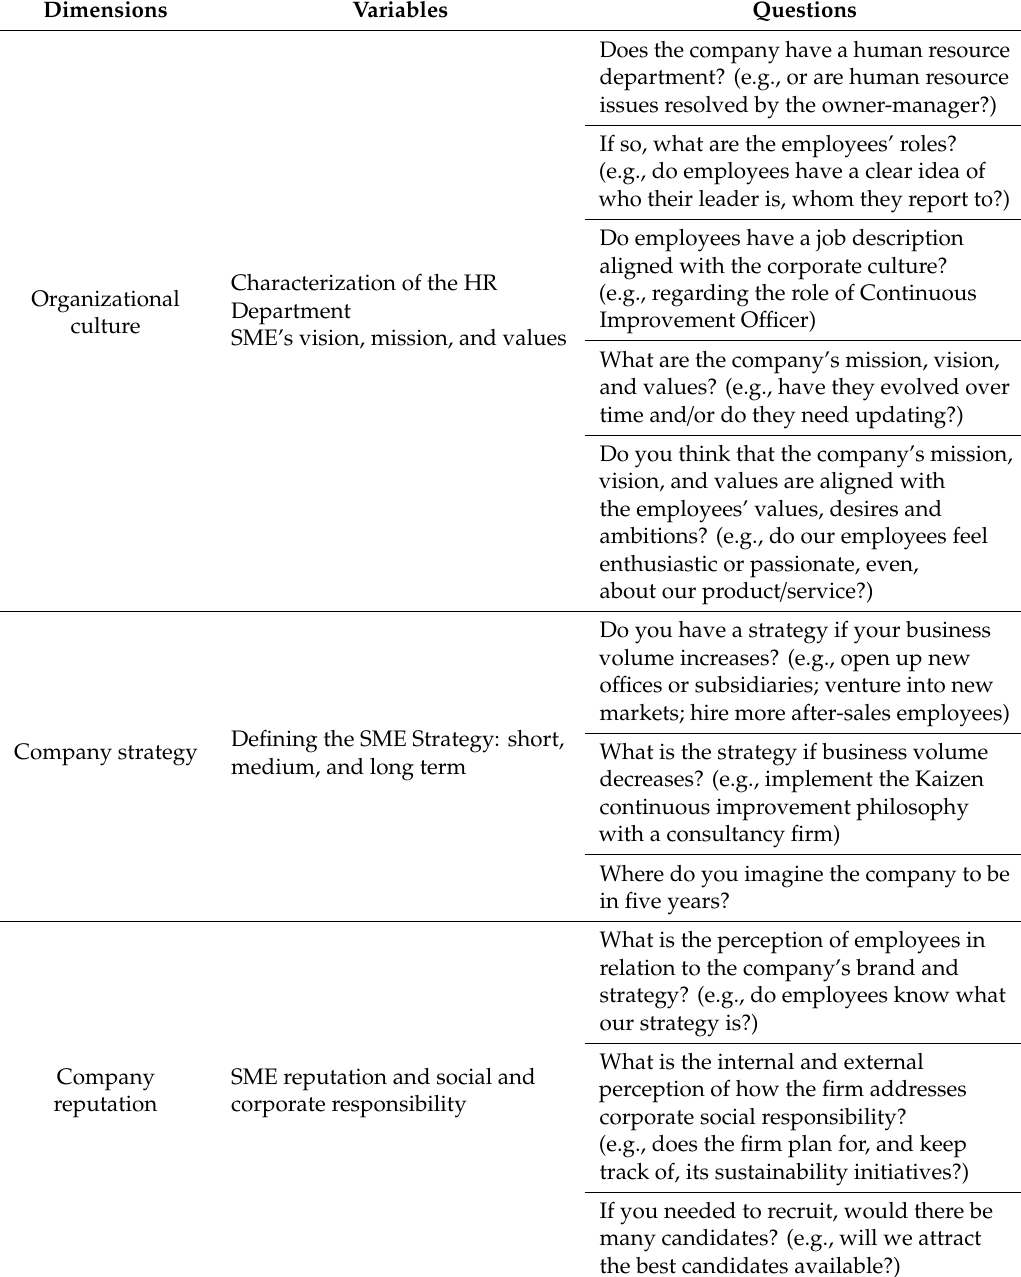
Table 1. Employer branding O C C S C R R S Model Questionnaire aimed at